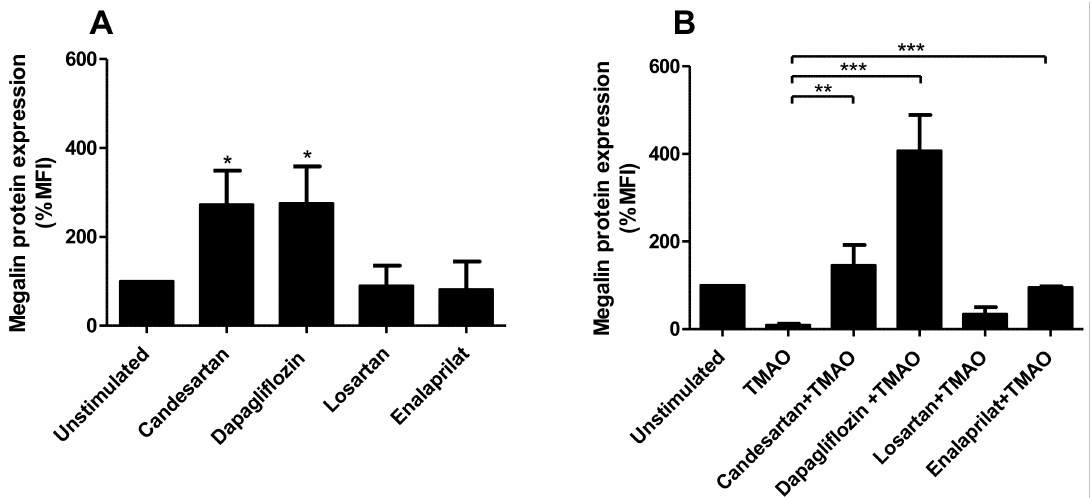
Figure 7. Candesartan, dapagliflozin and enalaprilat counteracts TMAO-induced reduction of megalin expression. HK-2 cells were treated with candesartan (10 µ M), dapagliflozin (10 µ M), losartan (10 µ M) or enalaprilat (5 µ M) for 12 h followed by assessment of megalin protein expression with flow cytometry analysis ( A ). Megalin expression was then evaluated in HK-2 cells stimulated with TMAO for 12 h, candesartan, dapagliflozin, losartan or enalaprilat was then added to the cells for an additional 12 h. Total exposure was 24 h for TMAO and 12 h for the drugs ( B ). Megalin protein expression is shown as % of unstimulated control. Data are presented as mean ± SEM (n = 3 independent experiments). MFI, mean fluorescence intensity. Asterisks denote statistical significance compared to unstimulated cells (* p < 0.05, ** p < 0.01, *** p <